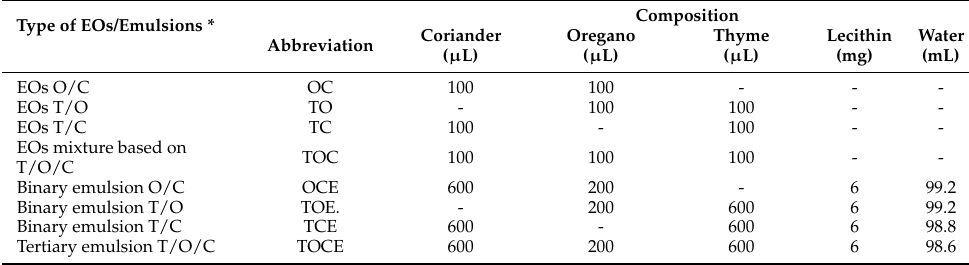
Table 1. The composition of EOs/emulsions used in the wheat seed